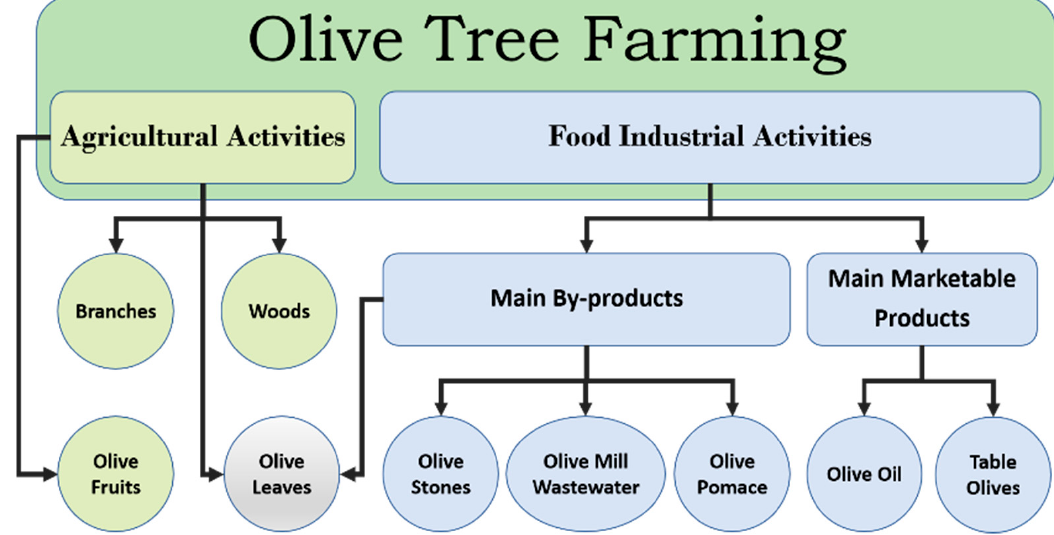
Figure 1. Major products and by-products produced from agro-industrial activities of olive fruits. Green technologies show potential for delivering optimal processing of olive oil products, and sustainable valorization of olive mill by-products, Although, there is a trend towards the processing developments in olive oil industry but, having said that, the proposed emerging methods have not quite reached the production system. The existing mechanical operations commonly used in both olive oil production and by-product re- utilization often represent (i) less efficiency of the processing of the main products, and (ii) low value applications of the processed by-products. This review describes the role of the processing on the fate of major phenolics in olive oil products and by-products and emphasizes the possibilities for a sustainable processing system that may enable achievement of the increased recovery of health-promoting phenols in olive oil, as well as improved valorization of olive mill by-products/residues that have the potential for high-value applications across various industrial